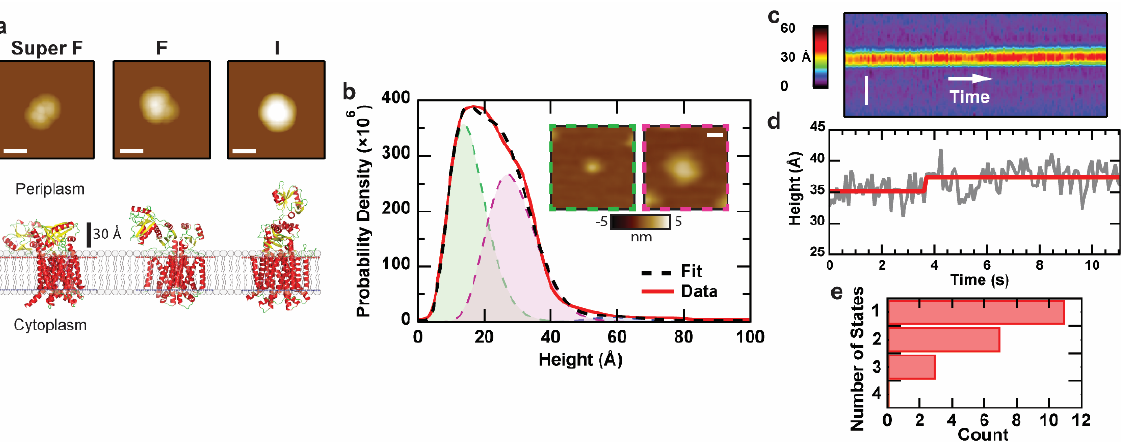
Figure 3. AFM imaging and kymograph analysis of SecDF in isolation. ( a ) Simulated AFM images of the periplasmic face of three SecDF structures: Super F, F, and I (5YHF, 3AQP, 5XAP respectively). The lateral scale bar is 10 nm, and pixel spacing is 5 Å. Bilayer background was determined based on the Orientations of Proteins in Membranes database. ( b ) Height distribution of SecDF protrusions ( N = 15,957). The peaks for the three Gamma distributions used to fit the model are located at 14, 27, and 60 Å, respectively. ( b , insets) Topographic asymmetry between the cytoplasmic (green dashed outline) and periplasmic (magenta dashed outline) face of SecDF. The lateral scale bar is 10 nm. ( c ) Representative kymograph and ( d ) corresponding height trace of an individual SecDF periplasmic domain, demonstrating minimal dynamics. The spatial axis is vertical (scale bar is 50 nm), and time is horizontal (90 ms per line), the grey line is the experimental data, the red line is the fit. ( e ) Histogram of the number of states detected across all SecDF kymographs ( N = 21). Only protrusions with heights corresponding to the periplasmic domain are considered here. Data are adapted from Ref.